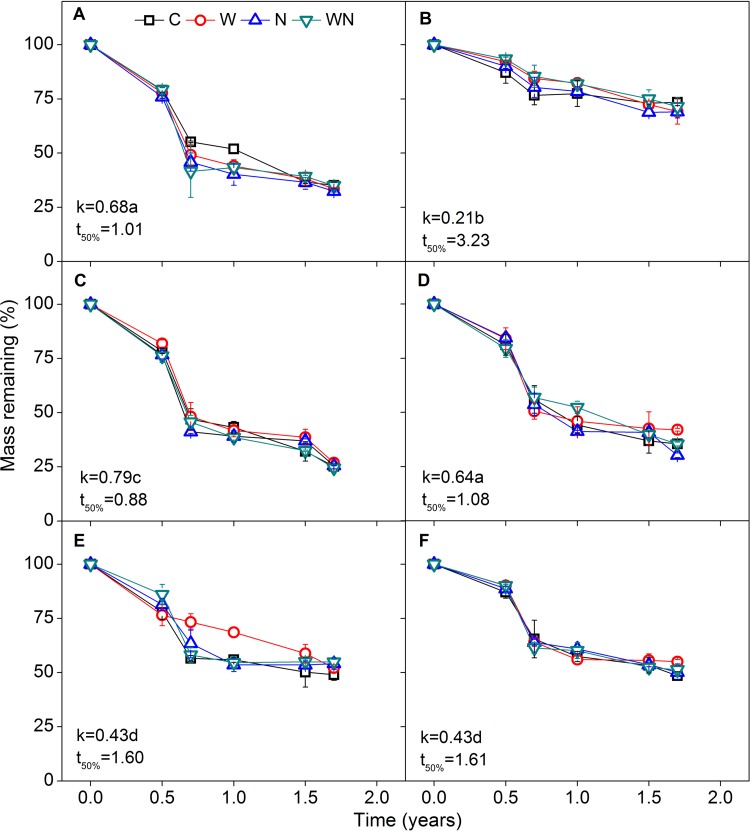
Residual mass of E. oxyrrhynchum (A), S. santolinum (B), S. subcrassa (C), P. communis (D), K. caspia (E), and N. sibirica (F) as affected by time after incubation for 1.7 years under control (C), water (W), nitrogen (N) addition, and water plus nitrogen additions (WN) in the field (experiment I).Values of k were determined using the negative exponential regression (X
t/X
0 = e
−kt) as proposed by Olson (1963). All k values present came from significant regression (P<0.01) with R
2 values within the range of 0.92–0.99. C, W, N, and WN treatments were averaged by species to calculate mean decomposition rates (k). Vertical bars represent standard errors (n = 3). Different lowercase letters indicate significant differences among species (P<0.05).